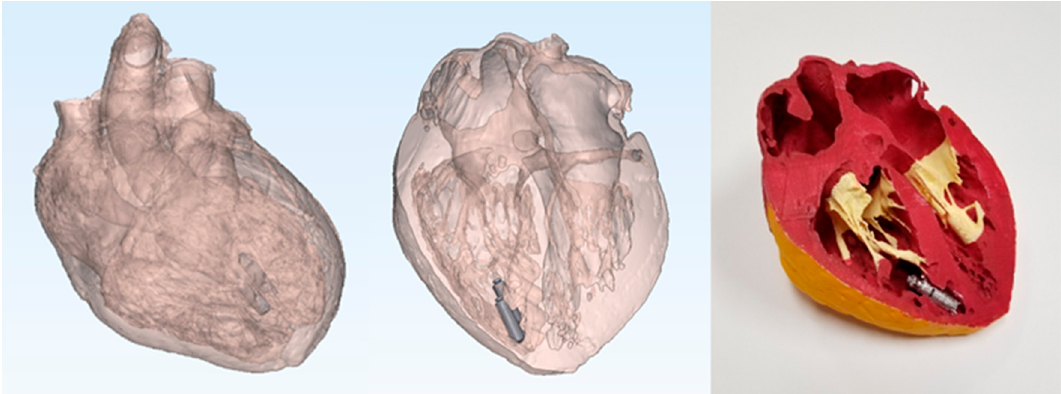
Figure 7. Multiple Micra TM transcatheter pacing systems computationally implanted in the right ventricular apex of a 3D human heart model (HH229; left) and resulting 3D print that was hand painted to study device–issue interfaces (right).